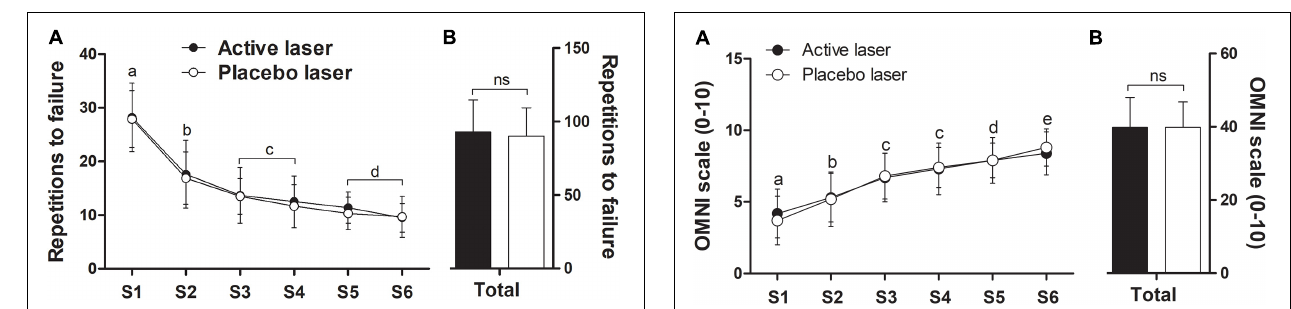
FIGURE 4 | Rating of perceived exertion (RPE) immediately before the next set began (after the 60-s rest) (A) and corresponding total RPE (sum of all sets, S1–S6) (B) of the repetitions-to-failure test in the active and placebo laser conditions ( N = 13). Data are means ± SD. There were no significant ( p > 0.05) differences over time between conditions. Different letters indicate significant ( p < 0.05) difference between time points for both